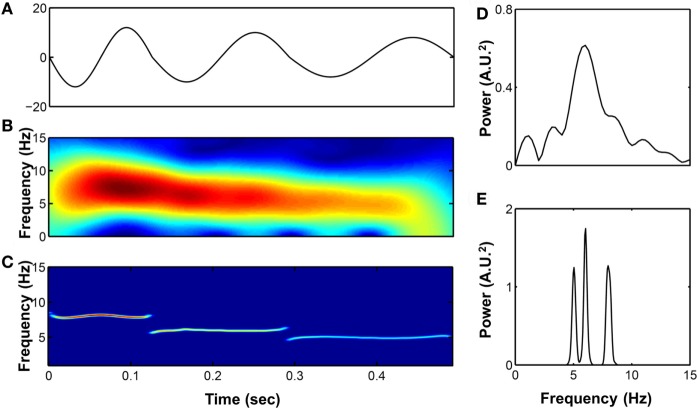
(A) A synthetic signal composed by three wavelets with different frequencies stitched together (8, 6, and 5 Hz, respectively). Its time–frequency representation were analyzed by short-time Fourier transform (B) and Hilbert–Huang transform (HHT) (C) as well as the power spectrum calculated by fast Fourier transform (D) and marginal spectrum calculated by HHT (E).